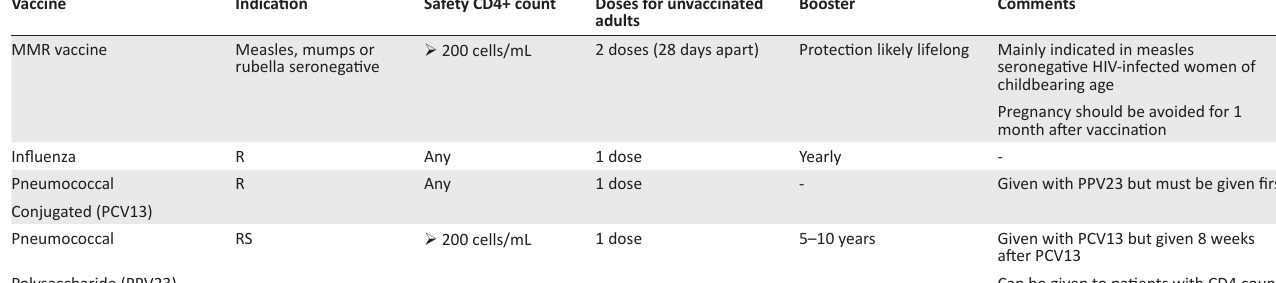
TABLE 1: Vaccination guidelines for HIV-infected adolescents and adults.